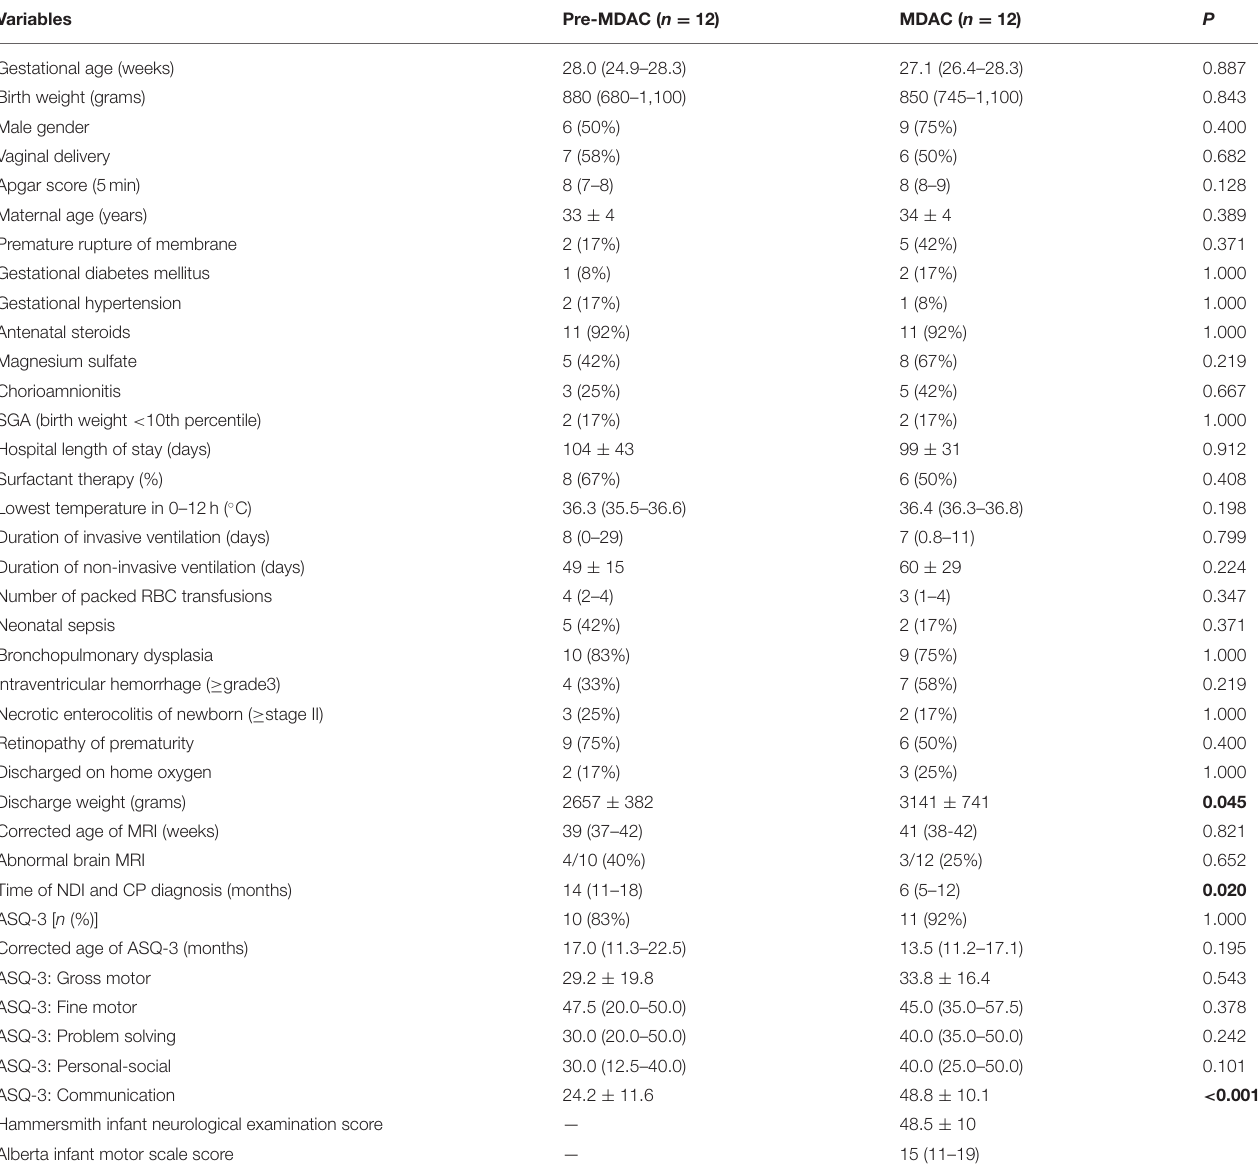
TABLE 4 | Demographic characteristics, main morbidity, and Ages and Stages Questionnaire (v.3) (ASQ-3) scores of infants with neurodevelopmental impairment during pre-MDAC (2015–2017) and MDAC (2018–2020) epochs.